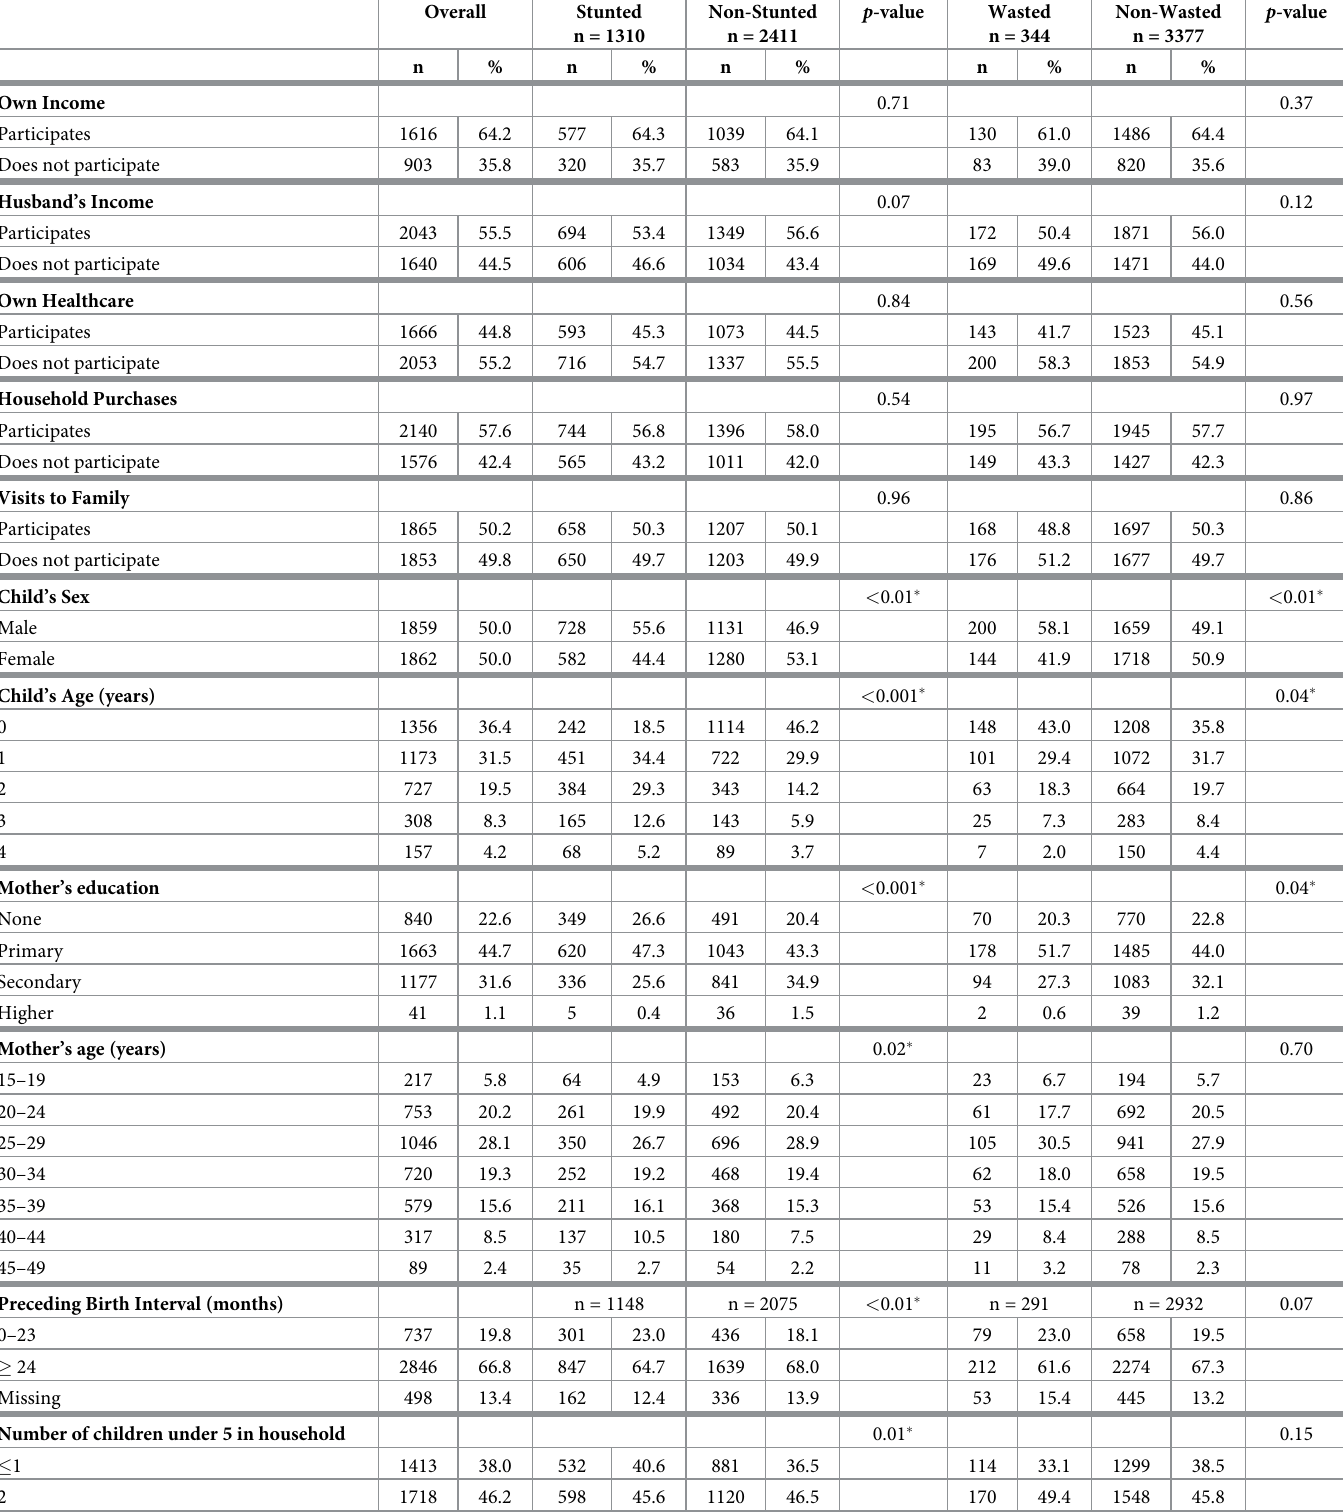
Table 1. Demographic characteristics of the study population (woman-child pairs) by nutritional